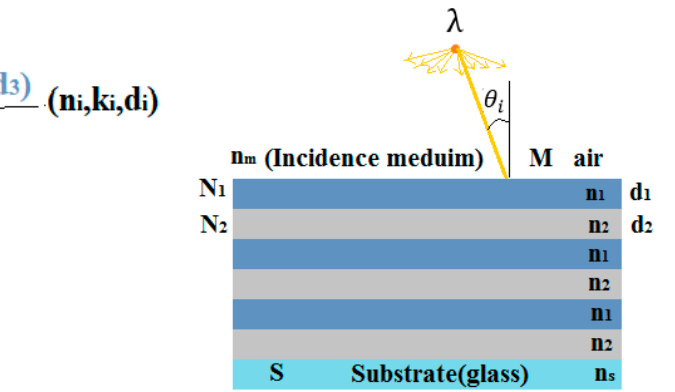
Figure 6. Unpolarized reflectivity versus wavelength for several conductors and dielectric materials calculated for normal incidence.